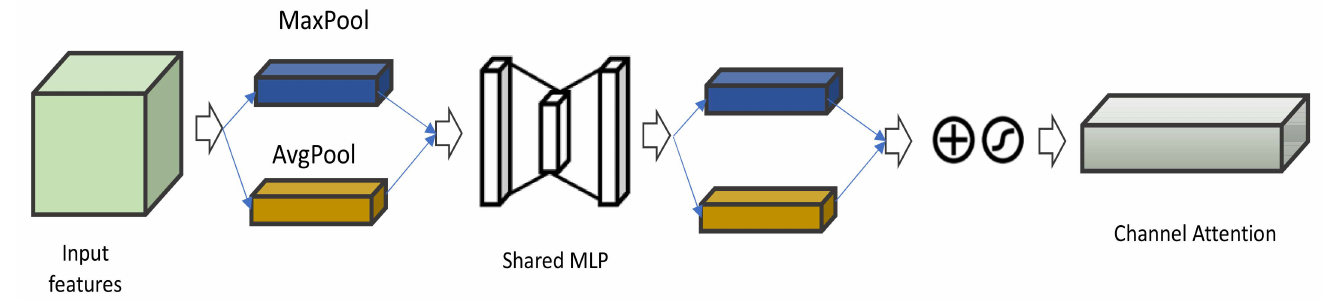
Figure 14. Illustration Channel Attention